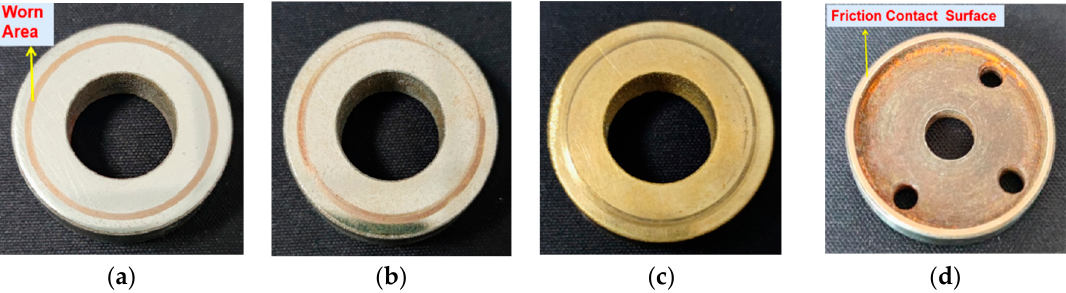
Figure 12. The samples after the friction and wear experiment: ( a ) sample with high-carbon steel coating; ( b ) sample with composite coating; ( c ) sample with aluminum bronze coating; ( d ) and paired sample in the experiment.